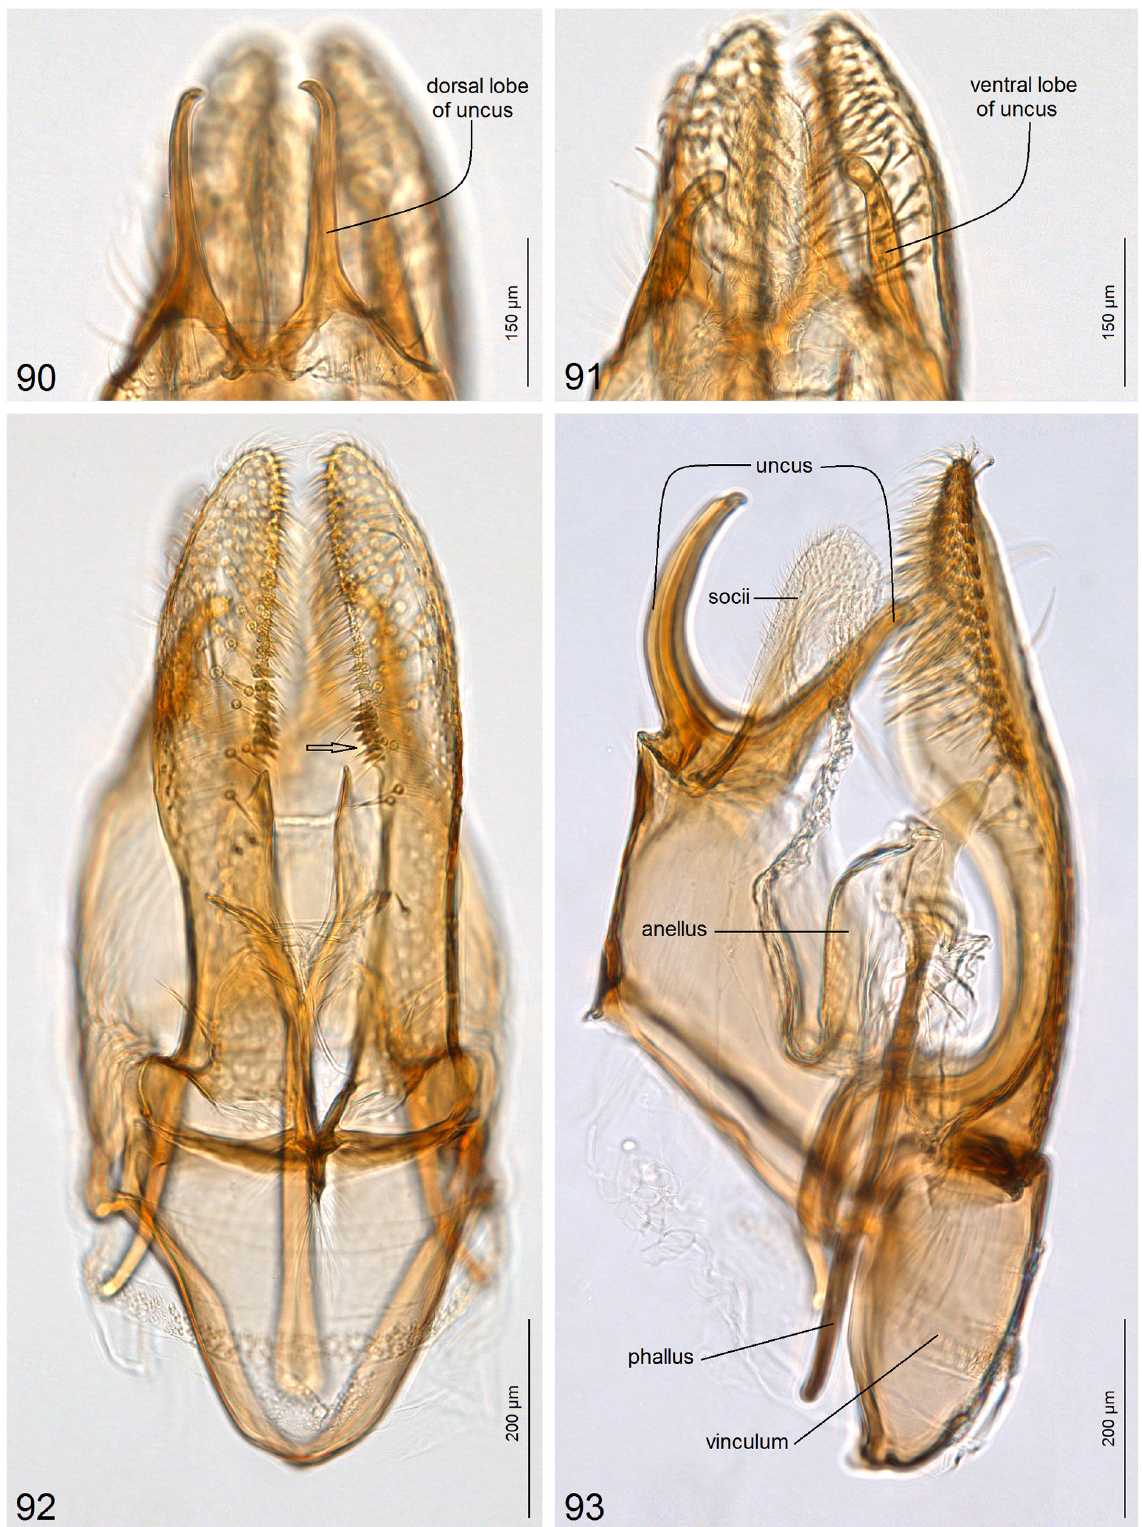
Figs 90–93. Male genitalia of Paratischeria robinsoni Diškus & Stonis sp. nov., holotype (genitalia slide no. 010316187, NHMUK). 90 . Uncus, dorsal lobes. 91 . Uncus, ventral lobes. 92 . Capsule with phallus inside, ventral view. 93 . Capsule with phallus inside, lateral